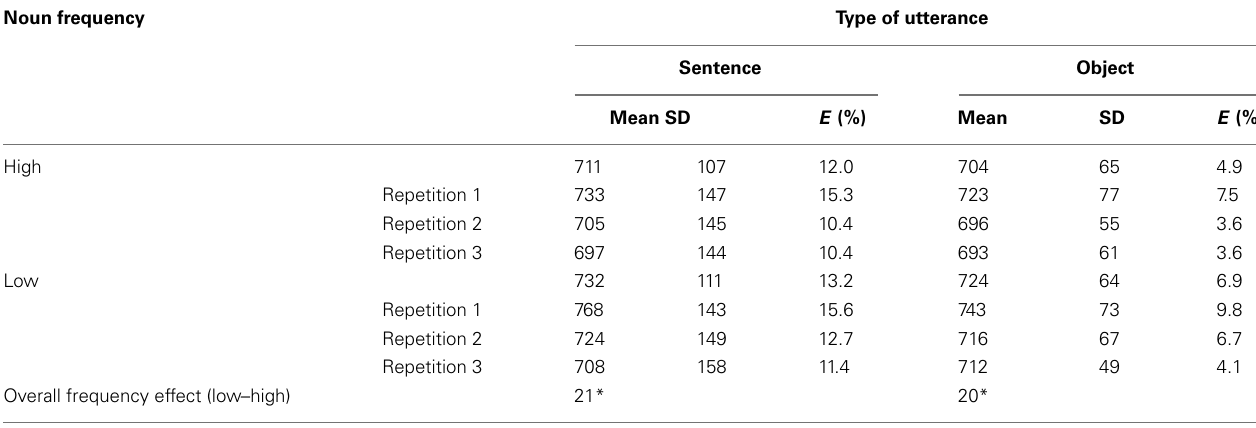
Table 2 | Experiments 2a (sentence naming) and 2b (object naming). Mean RTs (ms), SD, and percentage of errors ( E %), for high-frequency and low-frequency objects, across three repetitions, for both sentence and object